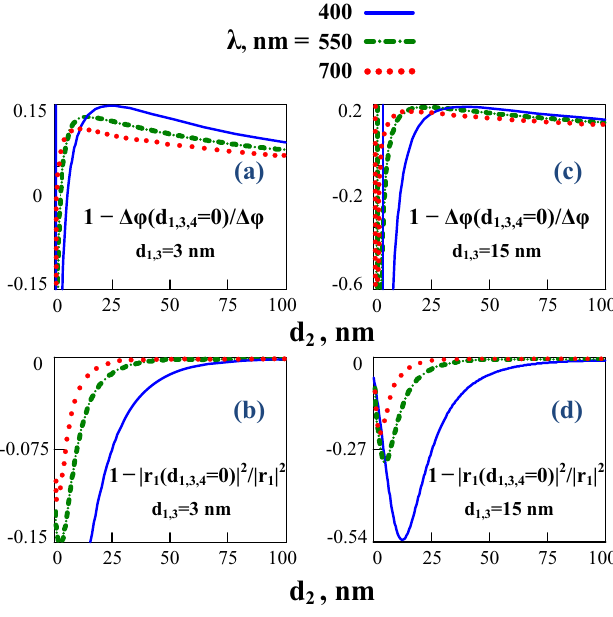
Fig. 14. Dependences of relative errors of PSD (a, c) and energy re fl ection coef fi cient (b, d) of wave 1 on the main layer (silver) thickness when the investigated multilayer is replaced by one main layer on the same substrate ( d 1,3,4 =0) for various wavelengths of the incident TM polarized wave. For all the graphs, thicknesses d 1,3 are given in the fi gures, d 4 =5 nm, c = p /6, e (cid:3) 0.2+ 0.1 i , m b = b =1, the spacer layers material is SiO 2 ( e 1,3 =2.13 +2.92 (cid:1) 10 (cid:3) 7 i , m 1,3 =1 [45,46]), and the addi- tional layer parameters are: e 4 = 3+0.5 i , m 4 = 1.5+0.2 i Fig. 13. Dependences of angle u (a, d), PSD of re fl ected waves (b, e) and corresponding energy re fl ection coef fi cients (c, f) on parameter m 0 b for the choice of various PCMs as the main layer material and TE polarization of the incident wave. The values of parameters are: d 2 =5nm (a – c), 50nm (d – f), for all the graphs c = p /6, d m 00 ¼ 0 : 2 , e m 0 b =2 +0.1 i . Parameter b b is used as 1,3,4 = 0, the abscissa axis for all the graphs.